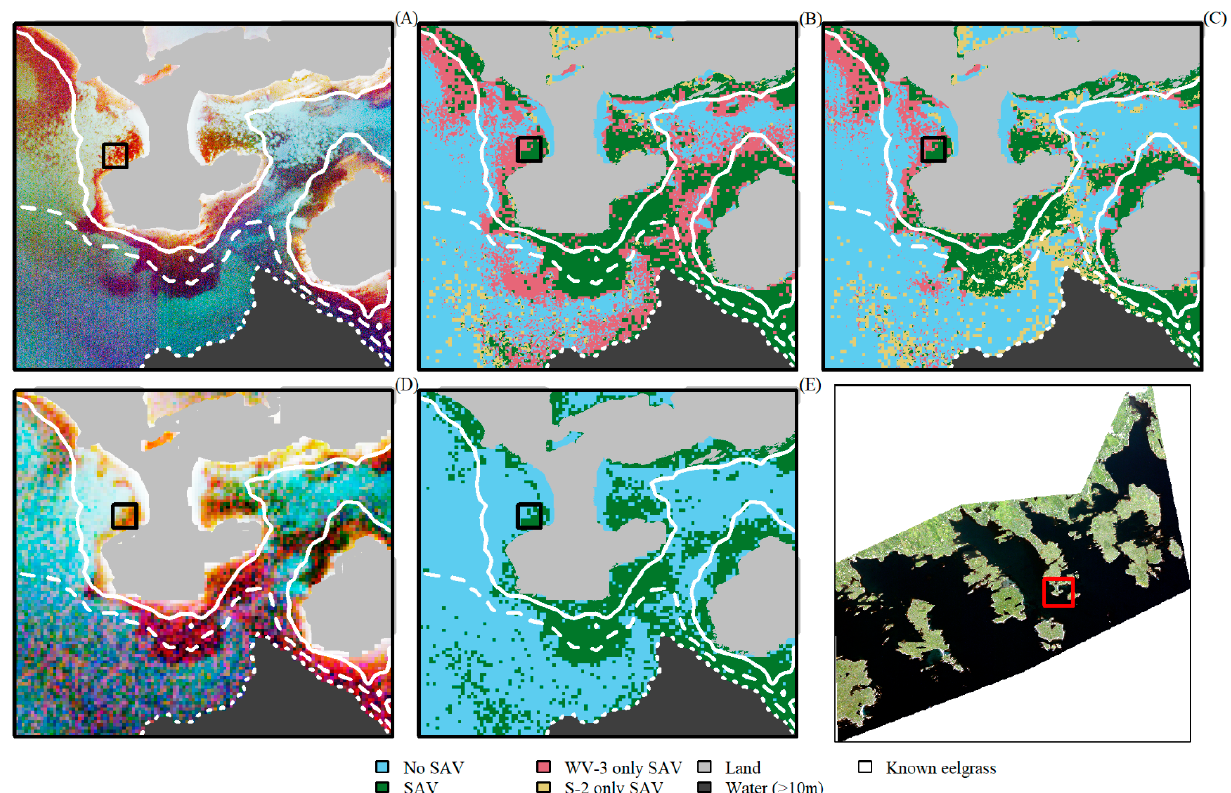
Figure 10. Comparing bottom habitat maps produced by the full tile Sentinel-2 (13 September 2016) and WorldView-3 (11 August 2019). True colour composite of WorldView-3 ( A ) and Sentinel-2 ( D ) are given for reference. Bottom habitat classification using the same methods (B-G-R) for the WorldView-3 image ( B ) indicating the difference to Sentinel classification ( E ). Top performing bottom habitat classification for the WorldView-3 imagery ( C ) indicating the difference to Sentinel classification ( E ). Known locations of vegetated habitat (specifically eelgrass) are indicated by the black boxes. Solid white line corresponds to the 3 m depth contour, long dashed white line corresponds to the 7 m depth contour, short dashed line corresponds to the 10 m depth contour. Light grey corresponds to an image-based land mask.